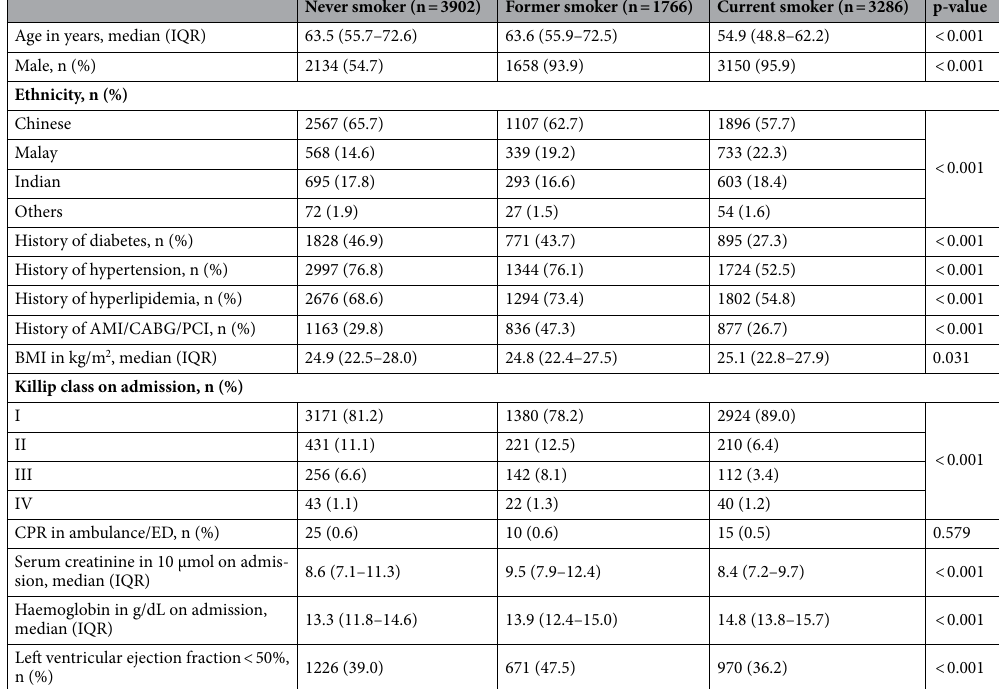
Table 2. Demographic and clinical characteristics of NSTEMI patients by smoking status. * AMI acute myocardial infarction, BMI body mass index, CABG coronary artery bypass surgery, CPR